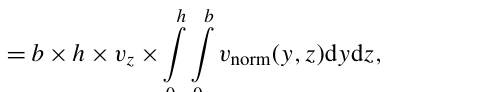
(1.2 and 2.4 Hz) as well as their respective time-averaged val- ues are shown. The pump was operated with a pressure of 50 kPa during pump cycles and a pressure of − 50 kPa during filling